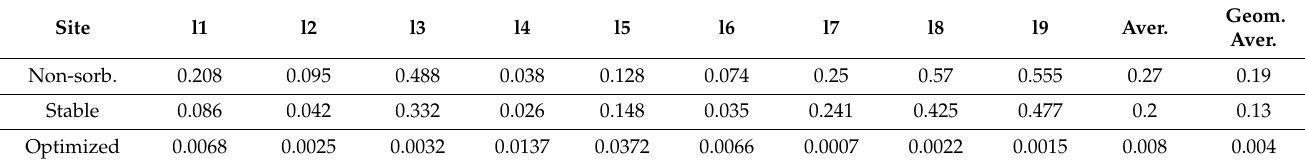
Table 4. Values of the relative criteria (%) for test sites for models derived from the non-sorbing tracer data, from the average of the stable tracers (“stable”), and for the optimized model. There are also (arithmetic) and geometric averages over all